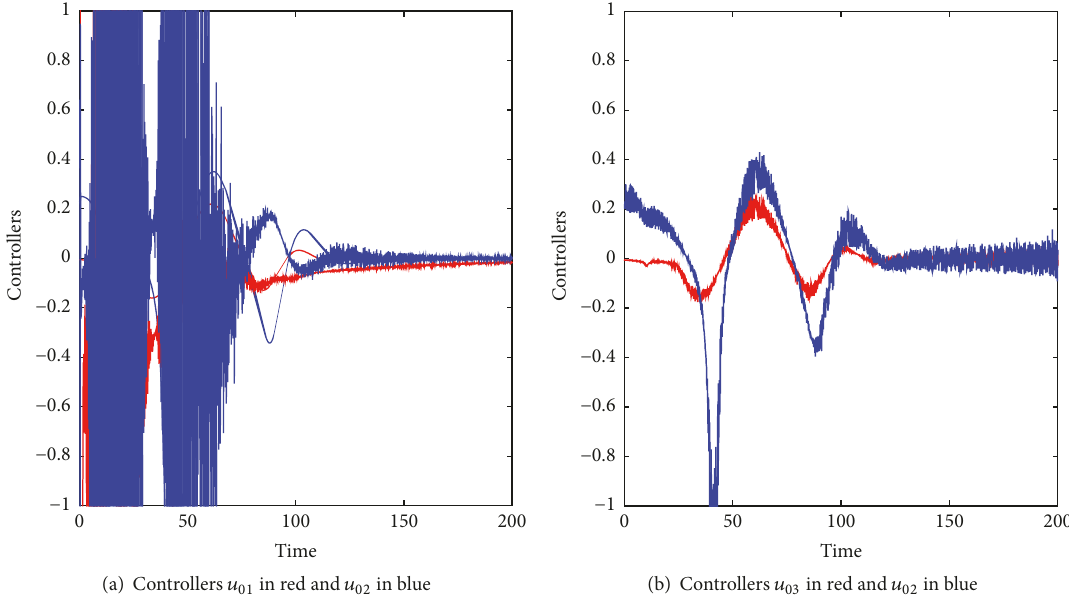
Figure 10: Controllers for end-effector of leader with 𝜎 = 0.1 .